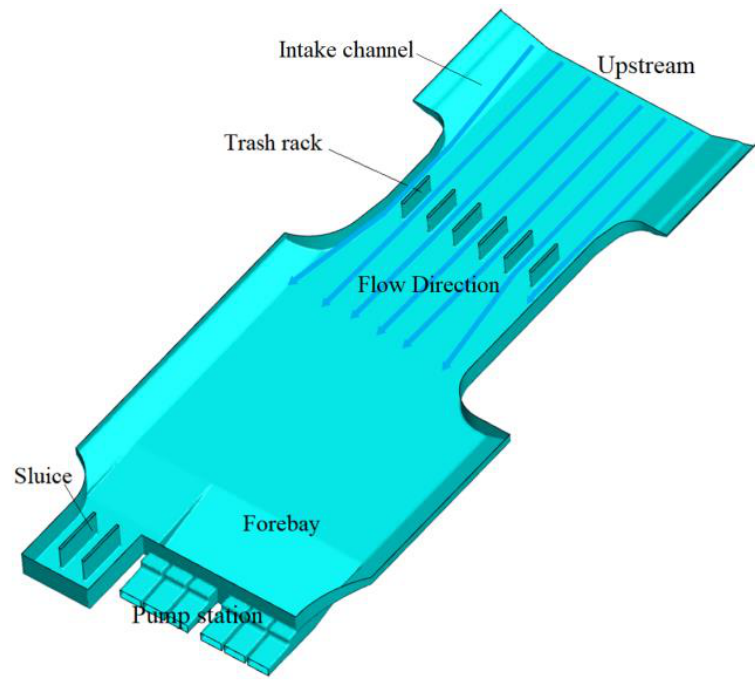
Figure 1. Computational area of the calculated model.